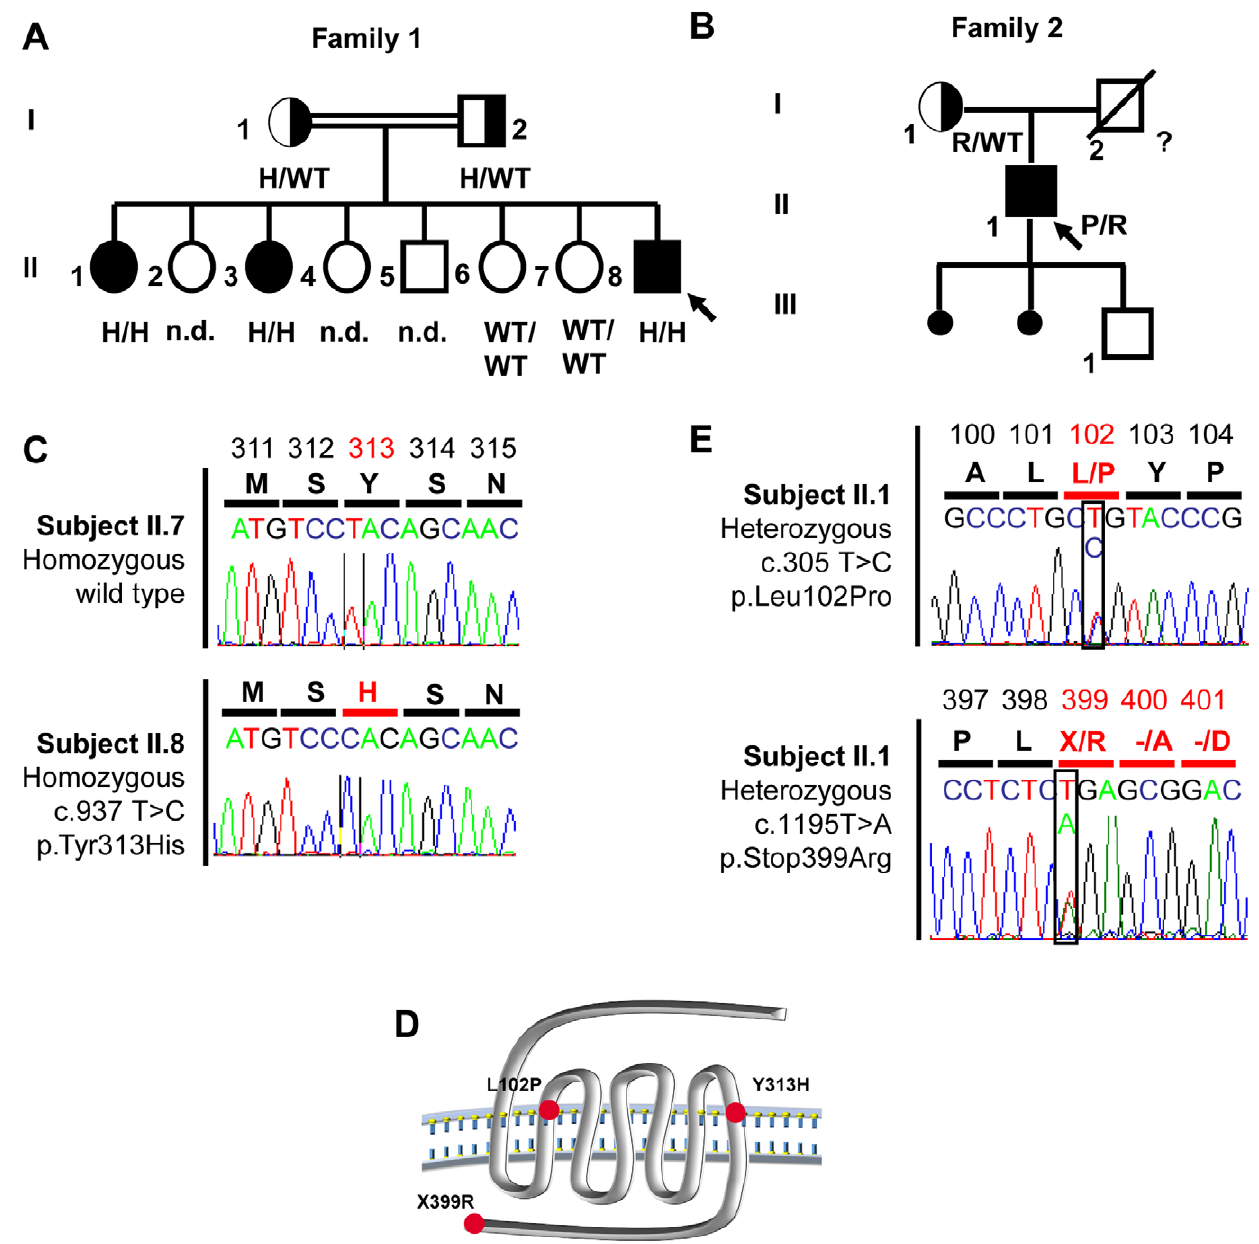
Figure 1. Family pedigrees and corresponding KISS1R mutations. Panel A. Pedigree of the family with homozygous KISS1R c.937T . C mutation. The proband, subject II-8 (arrow), and his two affected sisters, subjects II-1 and II-3, were homozygous for the c.937T . C mutation. The unaffected mother (I-1) and father (I-2) were heterozygous for the same mutation. Two unaffected sisters, II-6 and II-7, carried two wild-type alleles. This missense mutation (p.Tyr313His, (H)) is located in the seventh transmembrane segment. Squares represent males and circles females. Solid symbols indicate affected subjects and half-shaded symbols unaffected heterozygous. Panel B. Pedigree of the family with compound heterozygous KISS1R mutations c.305T . C and c.1195T . A. The proband, subject II-1 (arrow), was a compound heterozygote for the KISS1R mutations c.305T . C and c.1195T . A. The unaffected mother (I-1) was heterozygous for the c.305T . C mutation. The unaffected father was deceased and therefore unavailable for genetic analysis. The c.305T . C substitution produces a missense mutation (p.Leu102Pro, (P)) in the second transmembrane segment of KISS1R. The c.1195T . A substitution abolishes the natural stop codon (p.Stop399Arg, (R)). Small black circles indicate miscarriages. Panel C. Results of automatic DNA KISS1R sequencing encompassing the c.937T . C homozygous mutation in the propositus, compared to an unaffected control (lower panel). Inframe amino acids are indicated above each sequence. Panel D. Schematic representation of KISS1R and location of the mutations. Panel E. Results of automatic DNA KISS1R sequencing encompassing the c.305T . C and c.1195T . A compound heterozygous mutations in the propositus. Inframe amino acids are indicated above each sequence.